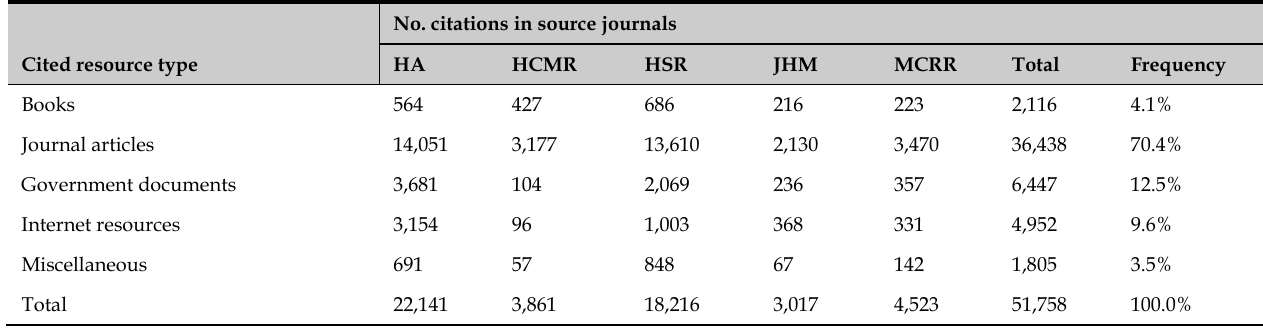
Table 1 Cited resource types by source journal and frequency of citations for all source